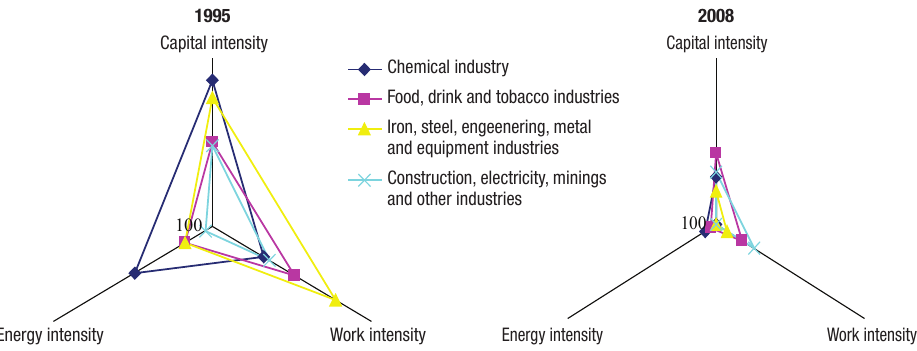
Fig. 12. Changes of export-oriented industrial sectors through industrial sectors in 1995 and 2008 Source: data from Tables 1, 2, 5, computed by